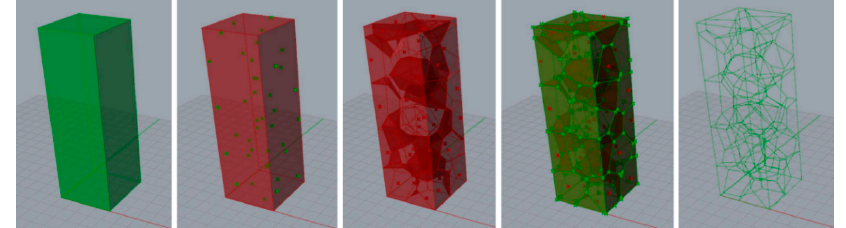
Figure 1. Procedure to obtain random structure from a space region by Voronoi tessellation.